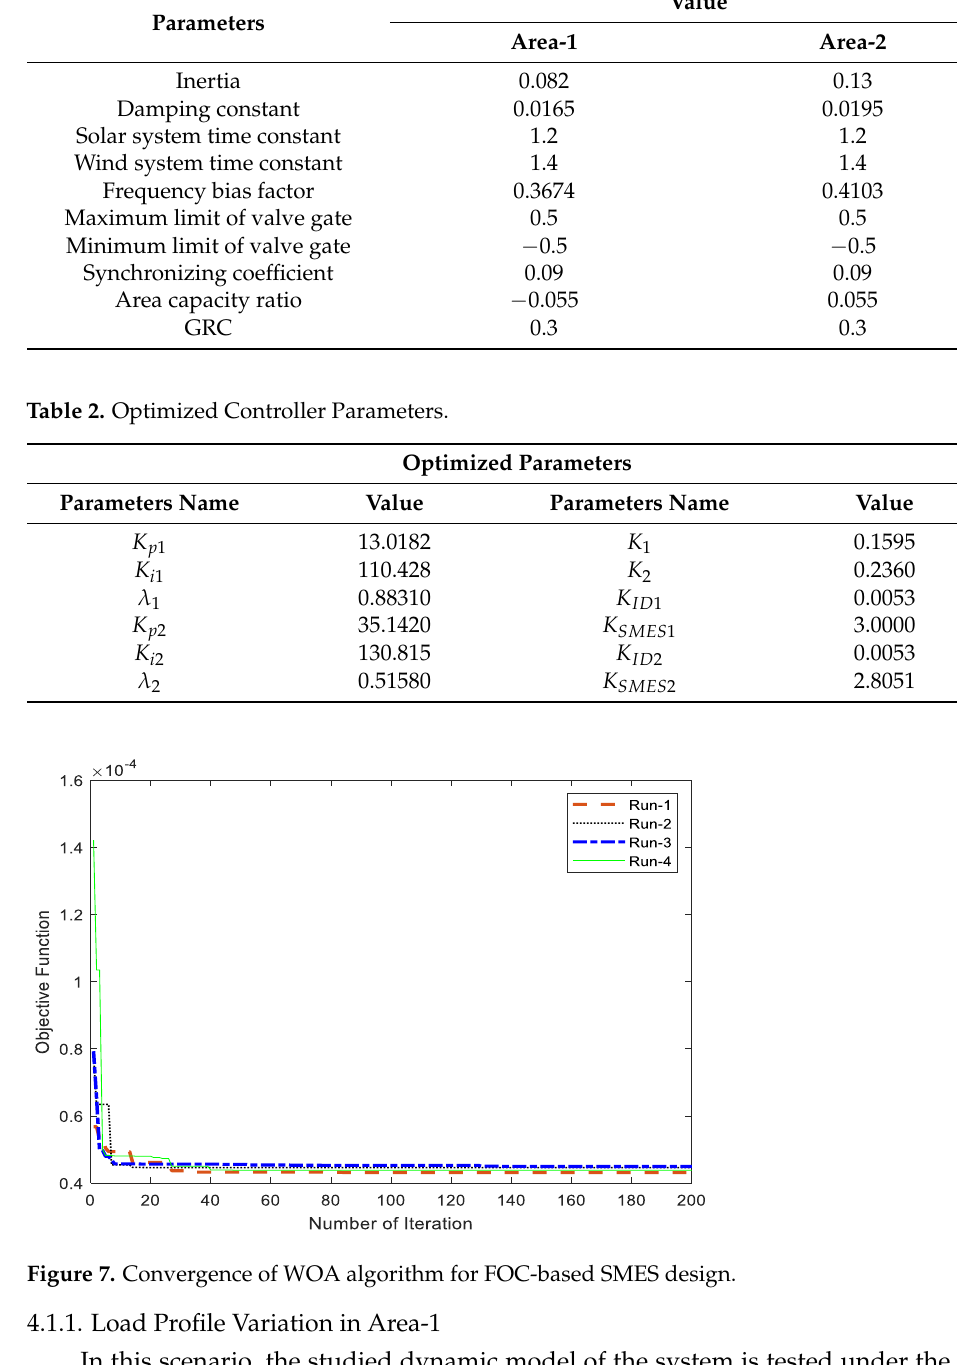
Table 2. Optimized Controller Parameters.